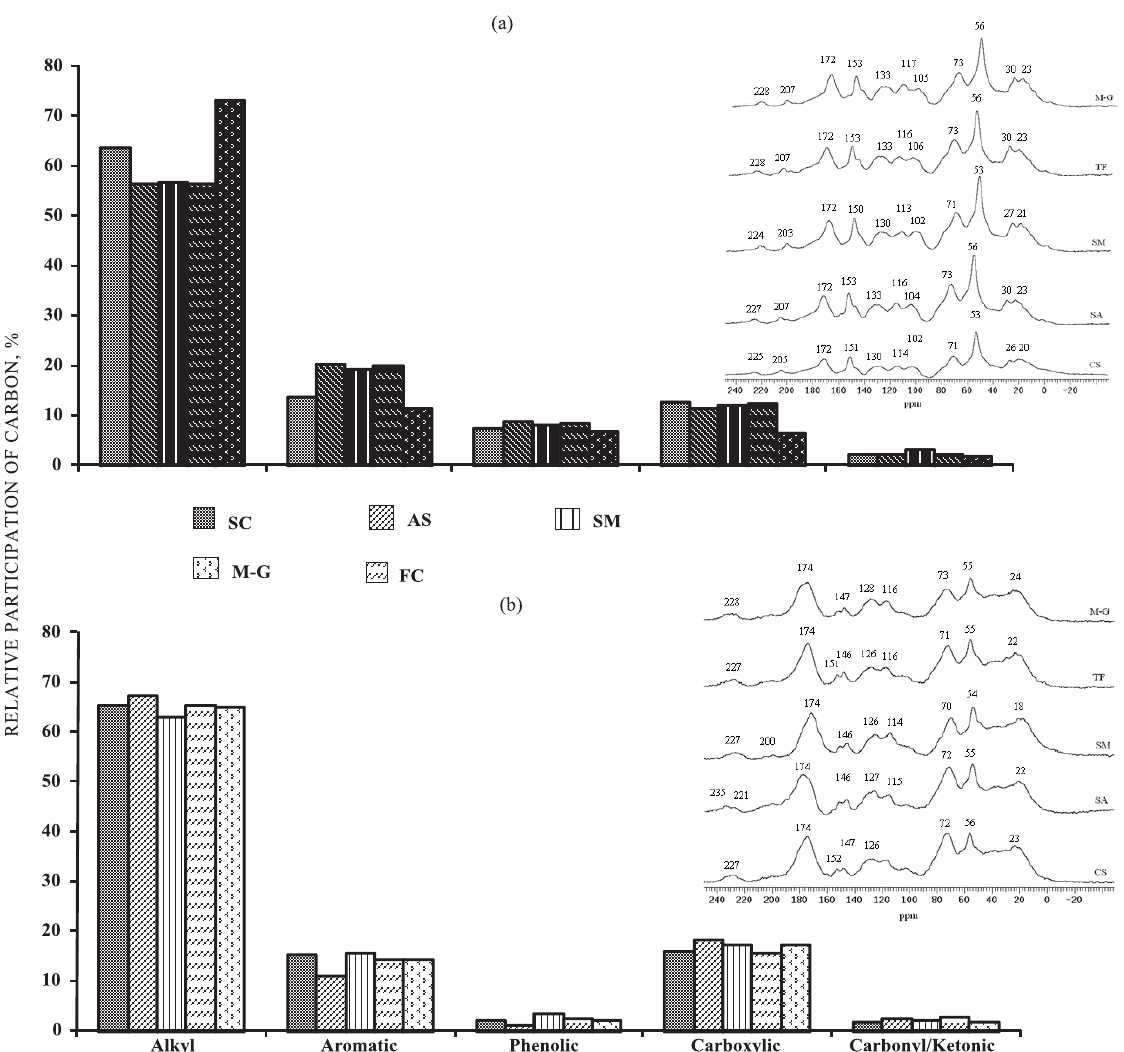
Figure 1. 13 C NMR spectra and carbon composition of humic acids (a) and fulvic acids (b) from composts developed from different materials and enriched with minerals. SC: simple compost; AS: SC + NPK, where N: ammonium sulphate; SM: SC + serpentinite and micaschist rock powder; FC: filter cake + sugarcane bagasse; M-G: castor oil plant residue + sugarcane bagasse.